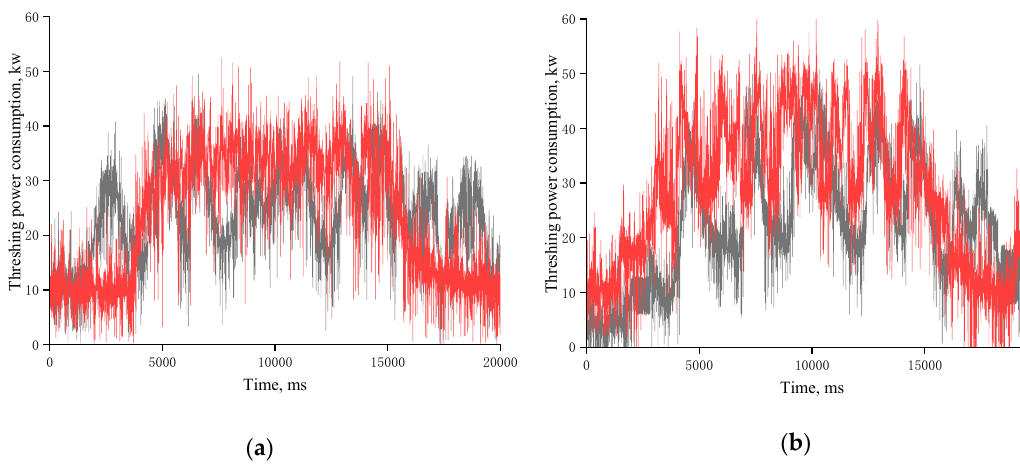
Figure 10. Diagram for the comparison in terms of threshing power consumption between both adjustment methods at the forward speed of 1 m/s, the red line is threshing drum adjustment type, the black line is concave adjustment type: ( a ) Threshing drum adjustment type and concave adjustment type with the threshing gap of 30 mm; ( b ) Threshing drum adjustment type and concave adjustment type with the threshing gap of 10 mm.